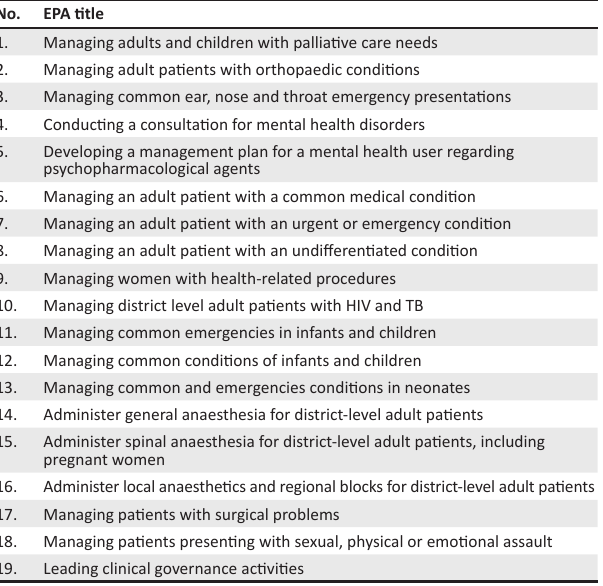
TABLE 1: Draft entrustable professional activity titles for postgraduate family medicine training in South Africa.